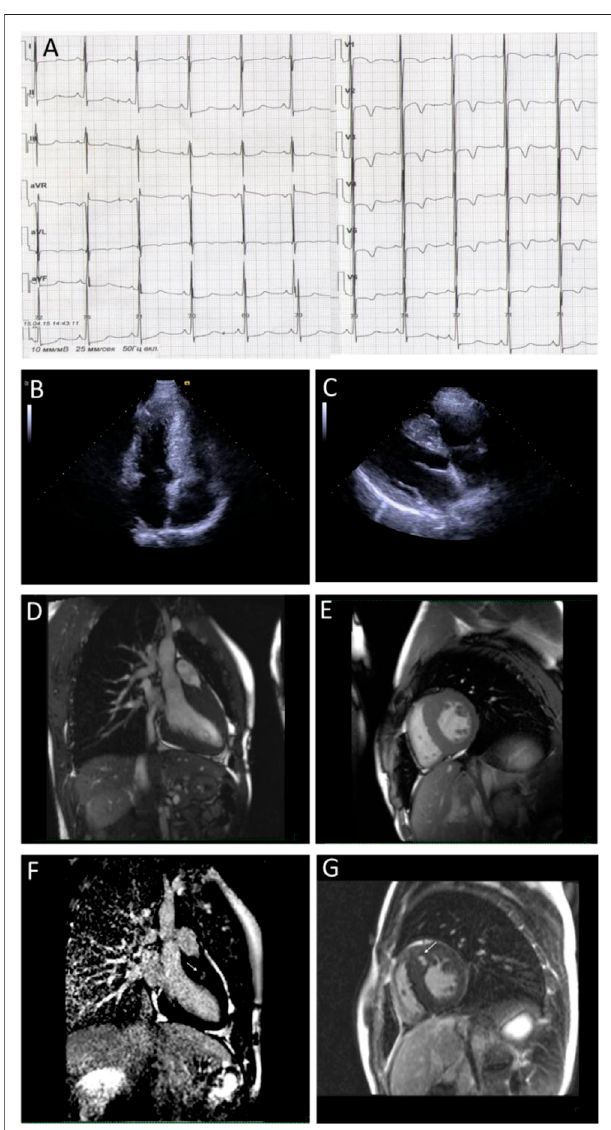
FIGURE 2 | Instrumental fi ndings of Patient 2. Electrocardiogram demonstrates voltage criteria of left ventricle hypertrophy and secondary repolarization changes (A) . Echocardiogram correspondence to four- chamber (B) and long-axis view (C) and MRI images in the long (D) and short-axis view (E) con fi rm wall hypertrophy. Arrows indicate the late gadolinium enhancement phenomenon (F,G) in the basal anteroseptal